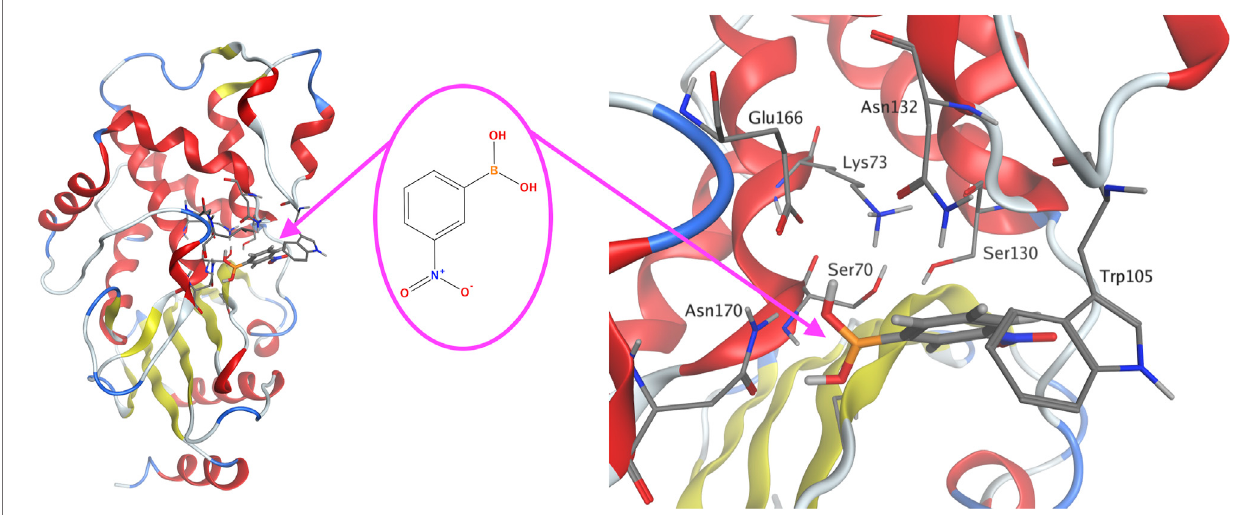
FIGURE3| KPC-2 β -lactamase withthedocked 3-NPBA substrate molecule (left) .The chemicalformulaof3-NPBA (middle) .The optimized molecular structure with an atomic resolution of KPC-2 β -lactamase focused on the active site with 3-NPBA docked (right) . The distance between Ser 70 hydroxyl oxygen and the boron atom of 3-NPBA was 2.57 Ă . The β -lactamase α -helices are shown in red, β -strands in yellow and turns in blue.